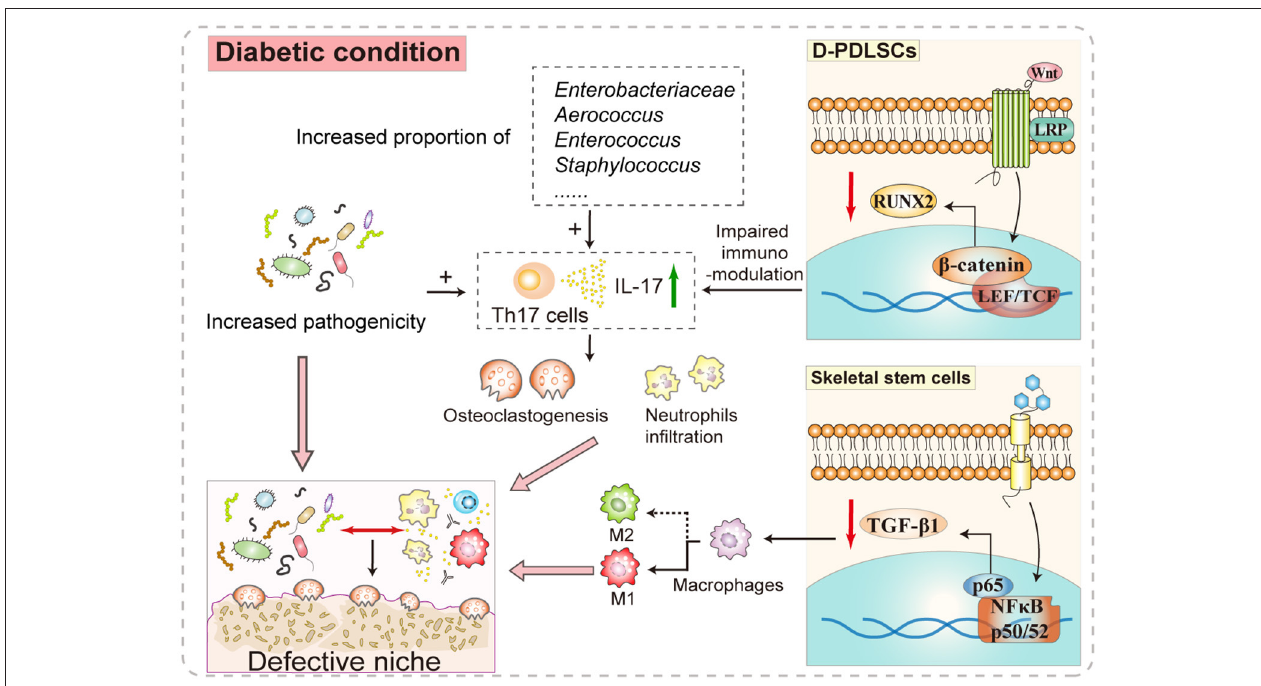
FIGURE 2 | The participatory role of diabetes in shaping the periodontal niche. The increased release of IL-17 in the oral microenvironment of patients with diabetes-associated periodontitis caused by the readjusted proportion and increased pathogenicity of the oral microbiome forms positive feedback with the disordered P-PDLSC immunomodulation, which intensifies the local inflammatory infiltration and osteoclastic activity. Besides, certain signaling pathways in stem cells are abnormally activated in the background of hyperglycemia. For example, P-PDLSCs have more obvious osteogenic disorders under diabetic conditions, which may be related to intracellular Wnt– β -catenin pathway activation. Another example is the aberrant NF- κ B signaling activation in skeletal stem cells reducing the secretion of the immunoregulatory factor TGF- β 1 and increasing M1 inflammatory polarization. Therefore, systemic factors may synergistically deteriorate the local stem cell niche-like microenvironment and influence periodontal